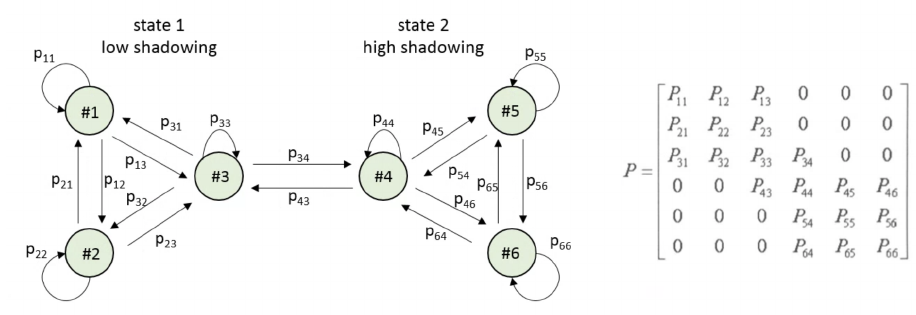
Figure 7. Six-state Markov channel